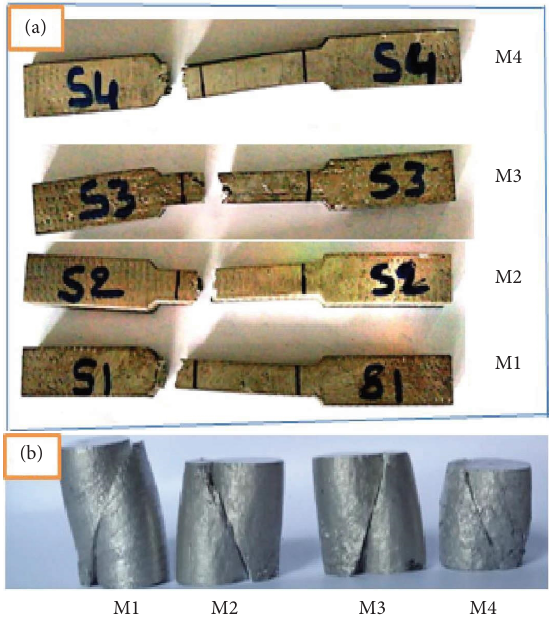
Figure 10: (a) Tensile and (b) compressive-fractured